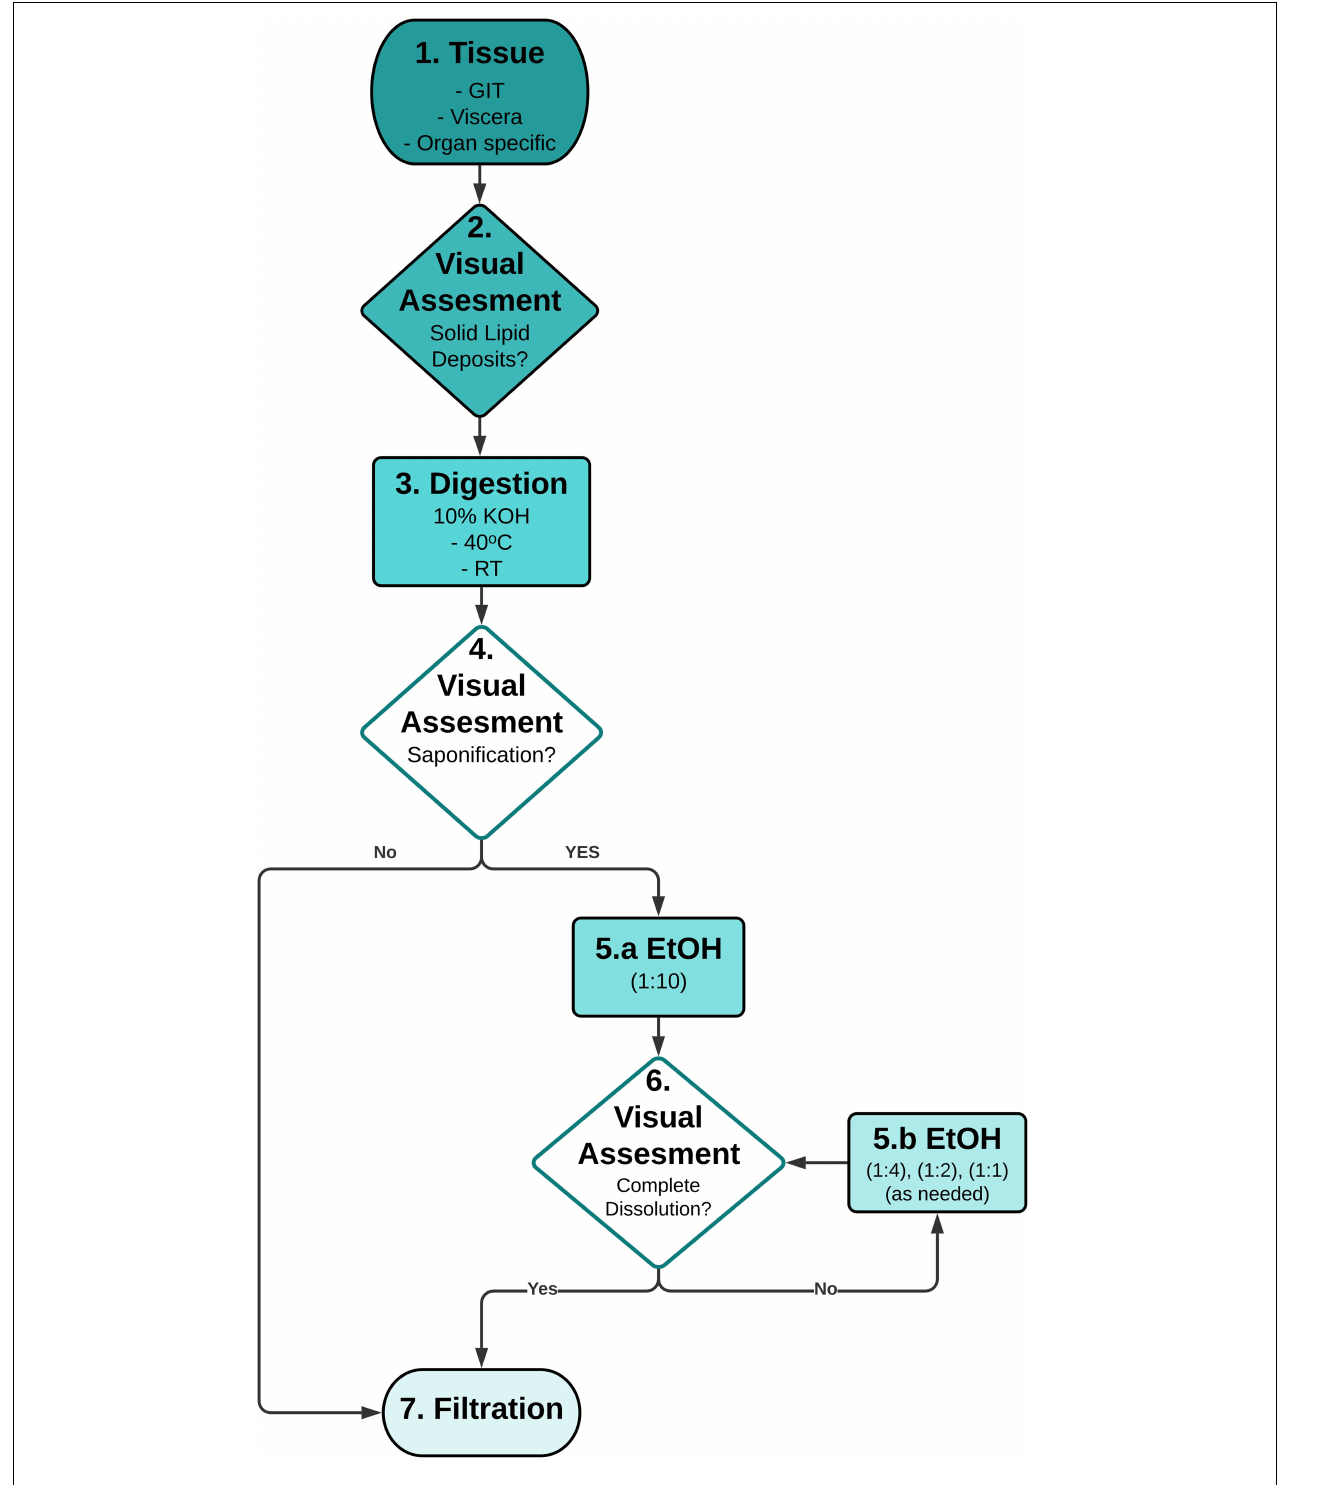
FIGURE 2 | Recommended workflow for dissolution of the gel formed in saponified potassium hydroxide (KOH) digestions. 1. Method is applicable to any desired fish tissue; 2. Optional: Removal of any excess solid lipid (fat) deposits attached to the tissue is recommended to reduce KOH/EtOH reaction volume; 3. Method is valid for both ambient and elevated temperature ( ≤ 40 ◦ C) KOH digestions; 4. Stage-gate using visual assessment ( Table 2 ) to process sample via filtration, or if saponification has occurred to treat with EtOH; 5a. Lowest concentration of EtOH is added; 6. Stage-gate using visual assessment to process homogenous solution via filtration, or if gel is still evident treat with EtOH; 5b. Sequentially add excess EtOH to dissolve the gel. 7. Filtration of homogeneous solution over suitable pore size filters to retain microplastics. GIT – gastrointestinal tract, EtOH – ethanol, RT - room temperature, solvent ratios - 100% EtOH: Biota/KOH solution, v / v .